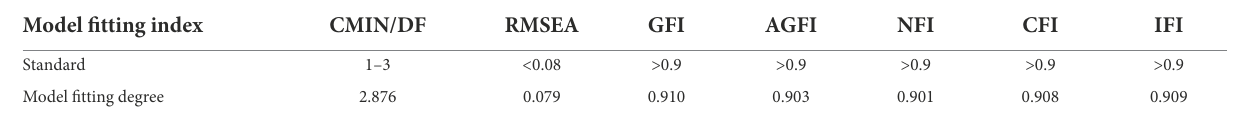
TABLE 4 Index table of model fitness.